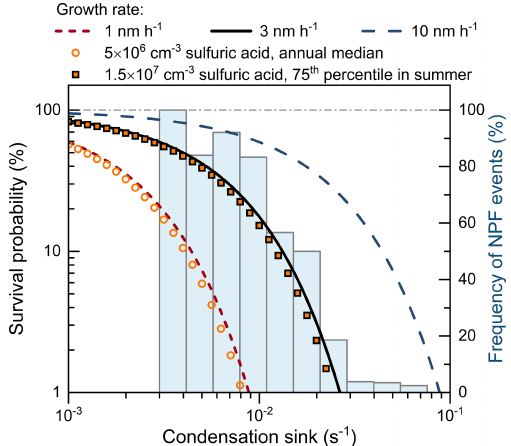
Figure 7. The theoretical survival probability of new particles and the measured frequency of new particle formation events in urban Beijing as a function of the condensation sink. The survival proba- bility is calculated for 3–10nm particles assuming an effective co- agulation sink, i.e., the mass accommodation coefficient is equal to 1.0. The condensation sink characterizes the size-dependent co- agulation sink during each new particle formation event. The NPF frequency is determined as the ratio of NPF days to all the mea- surement days within the given condensation sink range. This fig- ure shows that a 1nm h − 1 growth rate (or 5 × 10 6 cm − 3 sulfuric acid) is insufficient to explain the measured new particle formation in urban